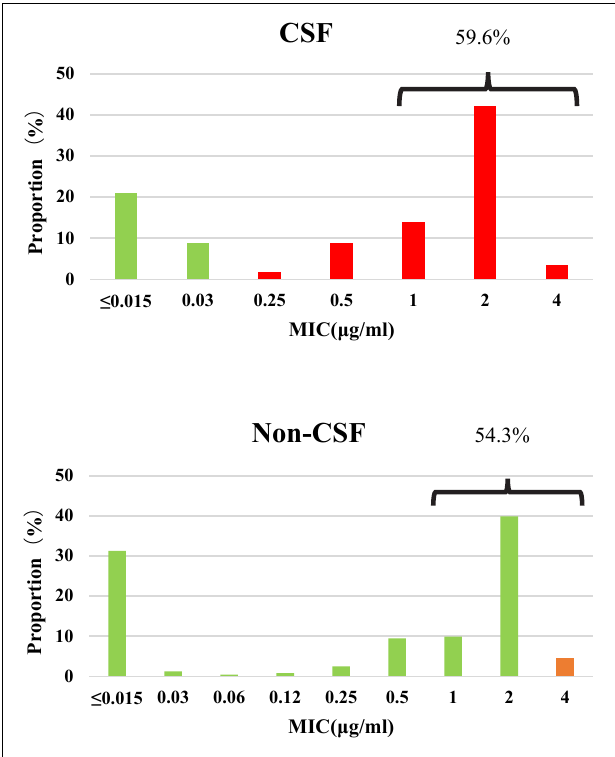
FIGURE 1 | Susceptibility and MIC distribution against penicillin in 300 S. pneumoniae isolates. Green: susceptible, orange: intermediate, red: resistant. CSF: PSSP 29.8%, PISP 0%, PRSP 70.2%; Non-CSF: PSSP 95.5%, PISP 4.5%, PRSP 0%.